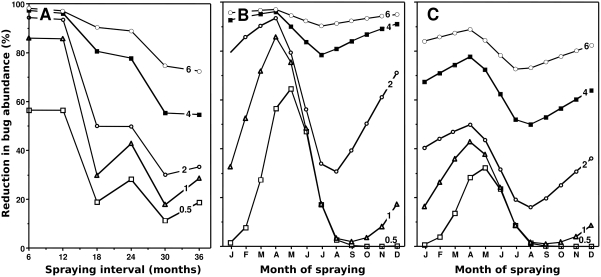
Effect of insecticide half-life.(A) Efficacy of repeated insecticide spraying as a function of the spraying interval and the insecticide half-life (indicated on each curve). (B) Efficacy of a yearly insecticide spraying. (C) Efficacy of spraying every two years.